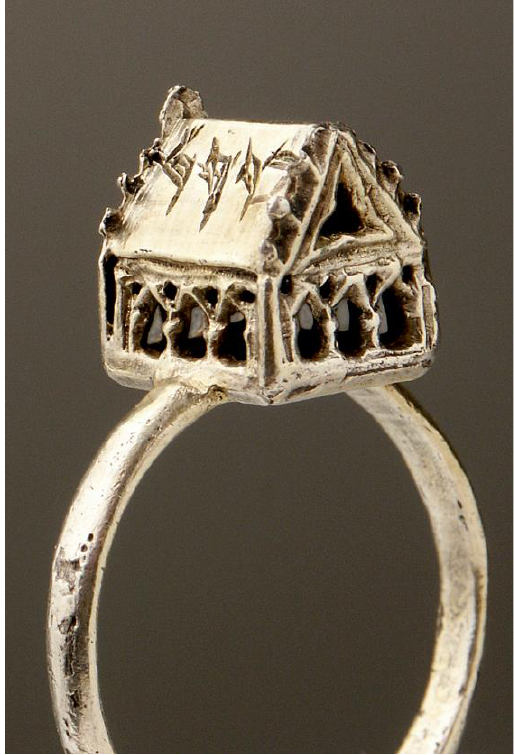
Figure 5. Erfurt Ring.